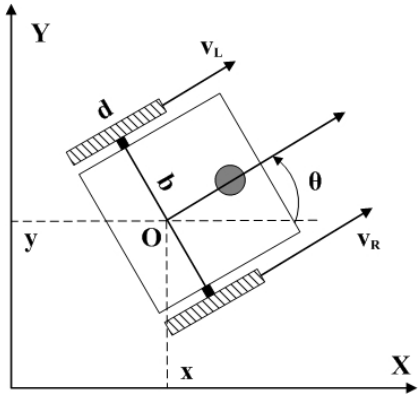
Figure 5. Computing model of the mobile node for 2D pose calculation.